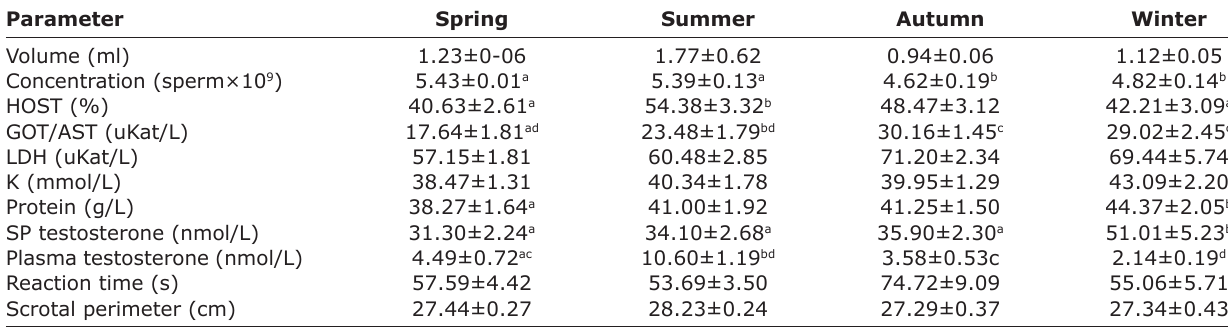
Table-2: Seasonal variation (mean±SEM) in semen and SP characteristics, and plasma testosterone concentrations, reaction time, and scrotal perimeter of MG and P bucks maintained under natural or artificial (2 months long days - 16 h light, 2 months short days - 8 h light) photoperiod throughout the